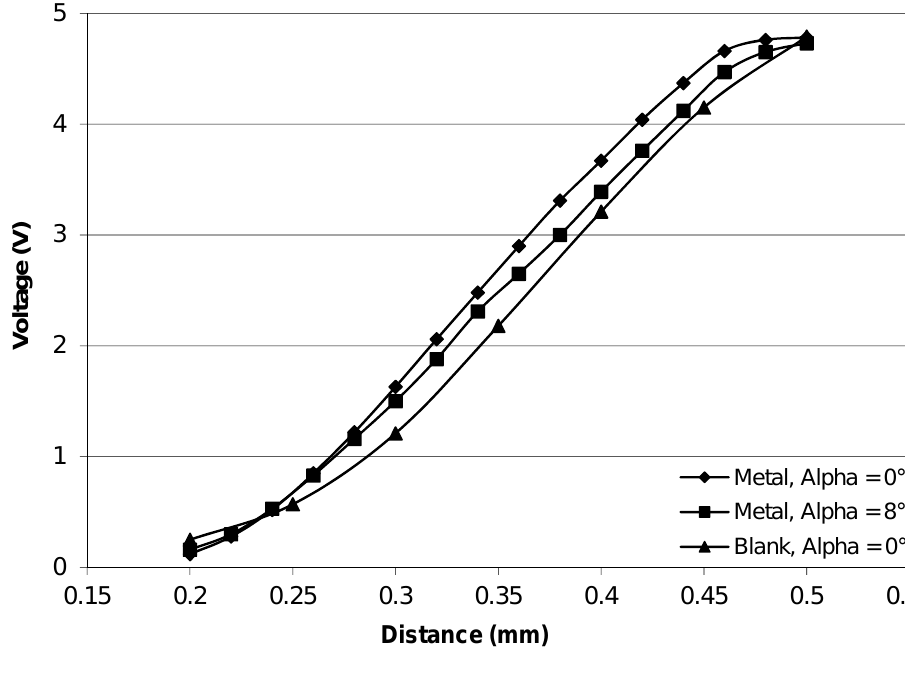
Figure 5. Influence of the tilt angle of the reflective surface on the sensor output. The curve is independent from the tilt angle in the linear